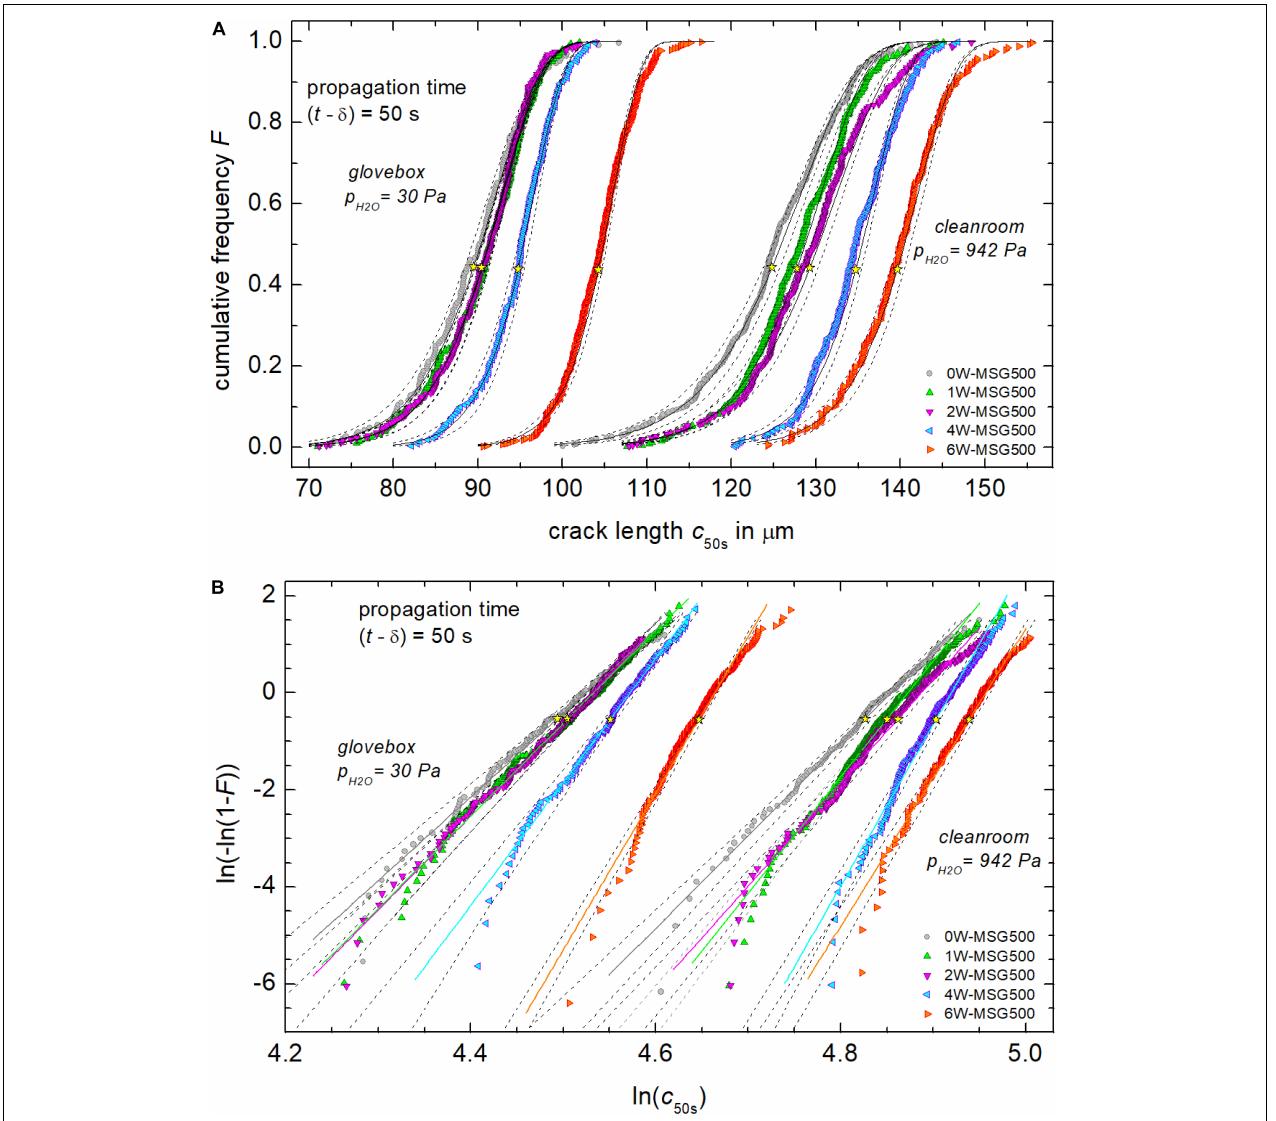
FIGURE 4 | Cumulative frequency F of the crack length c 50s in dry and humid environments (A) . Part (B) shows corresponding Weibull plots of cumulative frequencies. Solid lines are the best fit (MMR and MLE) through the data with parameters compiled in Table 2 , while dotted lines are 95% confidence intervals. Yellow stars indicate the mean crack length c av .